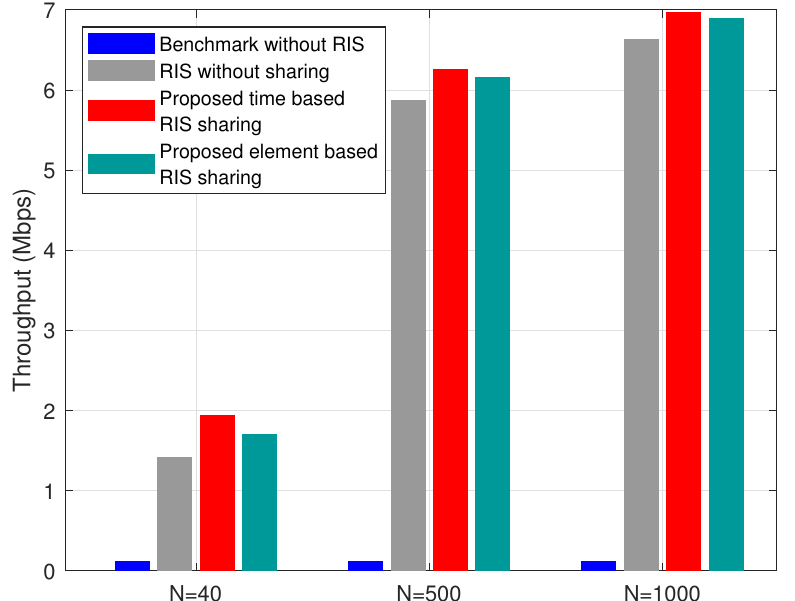
Figure 9. Variation of throughput with respect to number of of RIS elements N for µ u = 40%, µ pu = 20%, µ b = 6, and α =